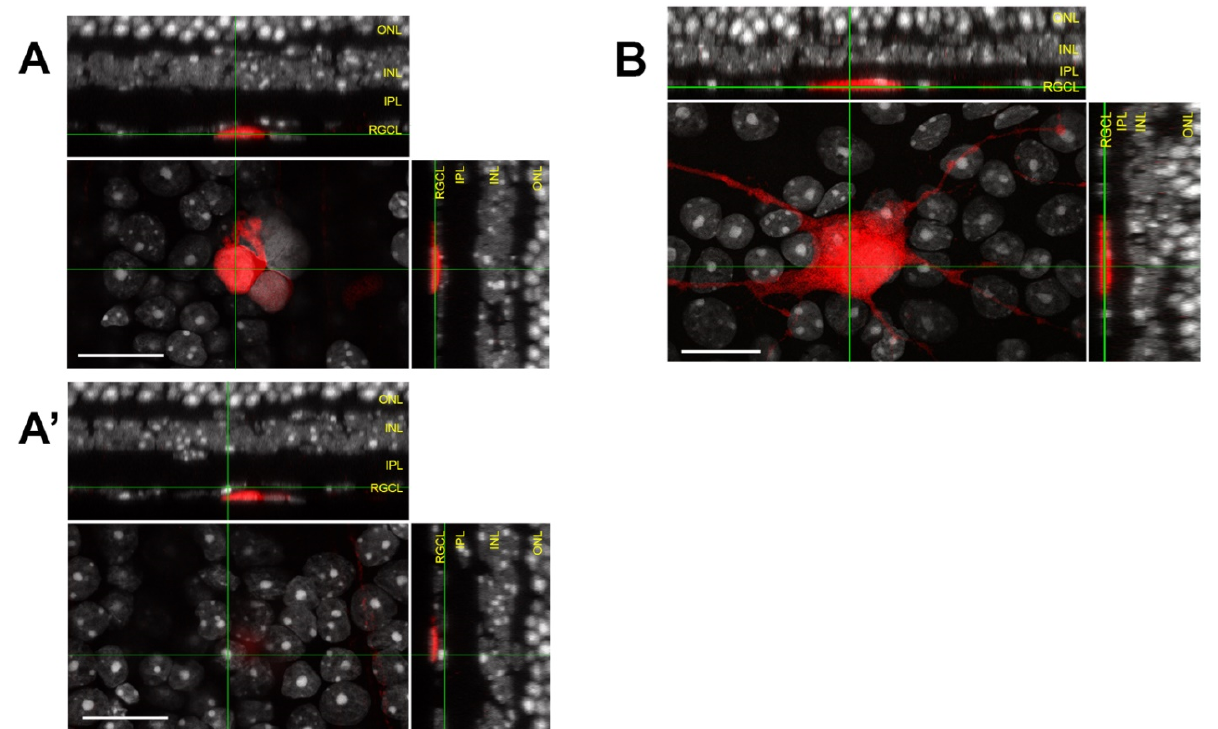
Figure 4. Orthogonal views from the same confocal microscope z-stack of two different planes ( A , A’ ) used to analyze relative planarity of donor RGC (red) and endogenous RGCs (grey). Donor RGC in ( A ) is situated in a superficial z plane as compared to the endogenous RGCs ( A’ ) underlying the same xy position. Example of a coplanar donor RGC (red) in ( B ) localizing to the endogenous RGCL, as indicated by the orthogonal views showing total coplanarity between the donor soma and nuclei of surrounding endogenous RGCs. Scalebars: 20 μm. RGCL—retinal ganglion cell layer; IPL—inner plexiform layer; INL—inner nuclear layer; ONL—outer nuclear layer.